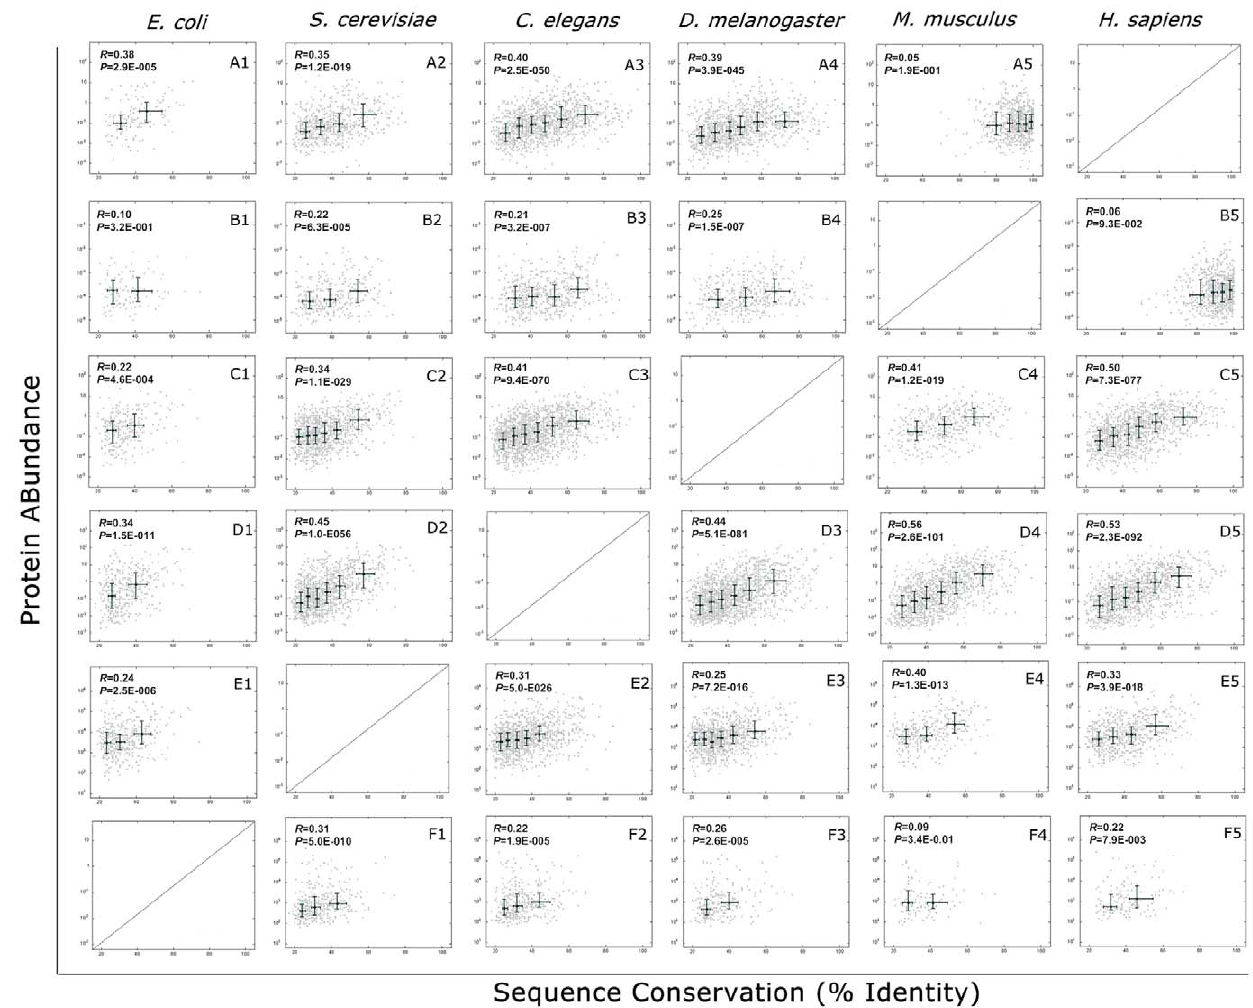
Figure 2. Proteome-wide correlation of proteins’ abundance with their sequence conservation across six species. The abundance of a given H. sapiens protein was plotted with its orthologue sequence similarity: H. sapiens vs. E. coli ( A1 ), S. cerevisiae ( A2 ), C. elegans ( A3 ), D. melanogaster ( A4 ), and M. musculus ( A5 ), respectively. The next five rows are for M. musculus ( B1–5 ), D. melanogaster ( C1–5 ), C. elegans ( D1–5 ), S. cerevisiae ( E1–5 ), and E. coli ( F1–5 ), respectively. Medians of equal-sized bins are indicated as crosses; whiskers encompass the range from 25% to 75% of values. The orthologs of every two species are indicated as dots in the background. The correlation coefficients ( R ) between sequence conservation and abundance are shown in the inset.